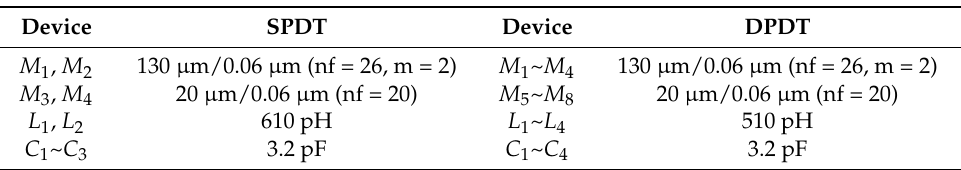
Table 3. The parameters of the devices used in the SPDT and DPDT switches (nf: number of fingers, m: multiplication factor).